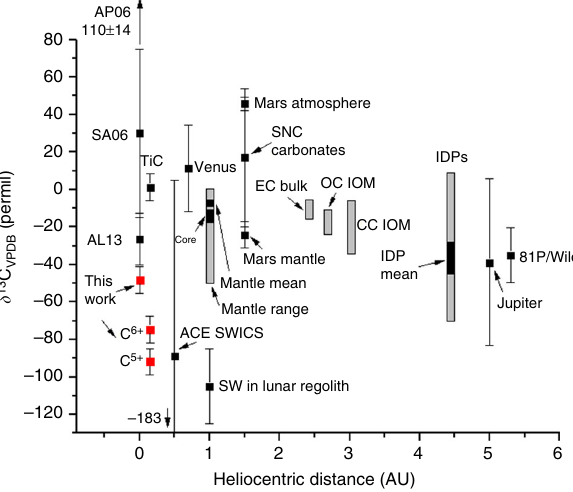
Fig. 4 Directly measured oxygen isotope ratios of the photosphere from ATMOS observations of CO. Genesis solar wind and inferred photosphere values also shown, together with theoretical mass-dependent fractionated values for inef fi cient Coulomb drag for O 6+ and O 7+ ions in the solar corona 42 (purple squares). The value for δ 18 O of the photosphere determined here (red square) is consistent with the inferred value from Genesis (black squares), and is distinct from a terrestrial value. All error bars are 1 σ . OC is ordinary chondrite (yellow); CC is carbonaceous chondrite (gray); CAIs are calcium-aluminum inclusions (light blue); hibonites (blue); bulk silicate Earth (green circle); bulk silicate Mars (red circle). The terrestrial fractionation line describes the array of O isotope values for the vast majority of materials on Earth; it has a mass-dependent slope of about 0.52